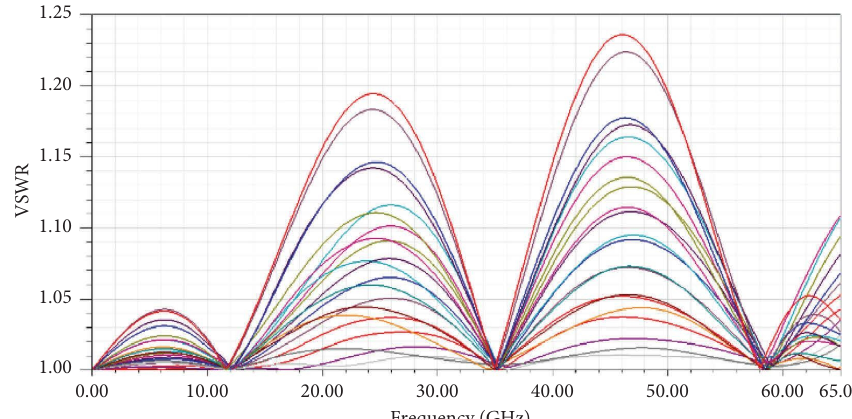
Figure 5: Simulated VSWR values for each set of structural